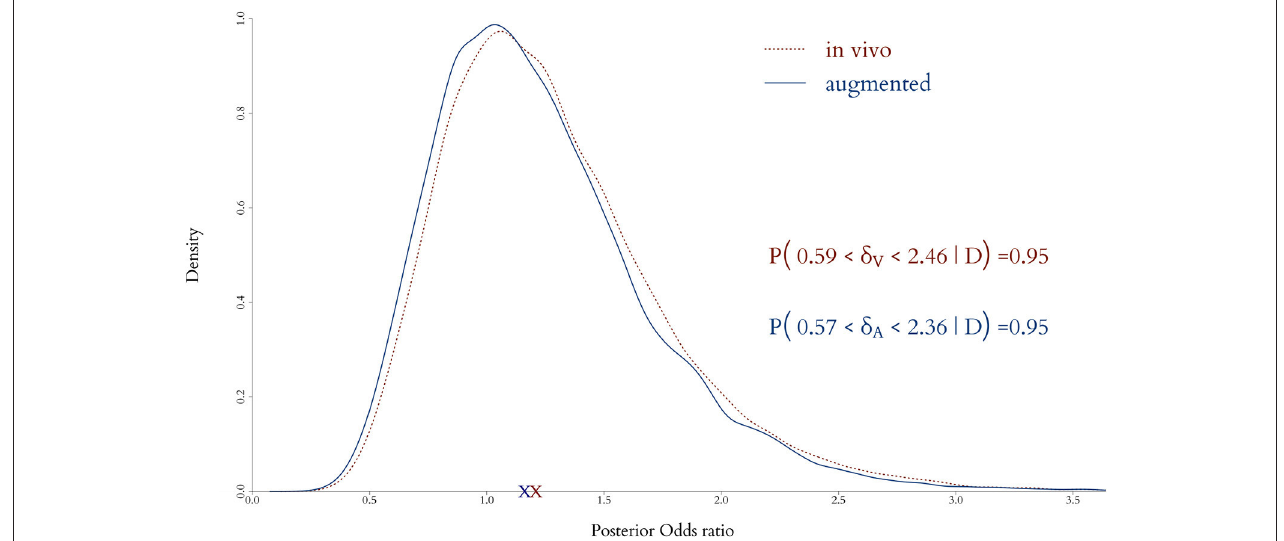
FIGURE 8 | Posterior distributions of odds ratio when only the in vivo cohort is fitted and when both the in vivo and in silico cohorts are combined for the full model. Adding virtual patients does not alter significantly in the posterior expected odds but provides a decrease in the uncertainty in the estimation of the clinical end